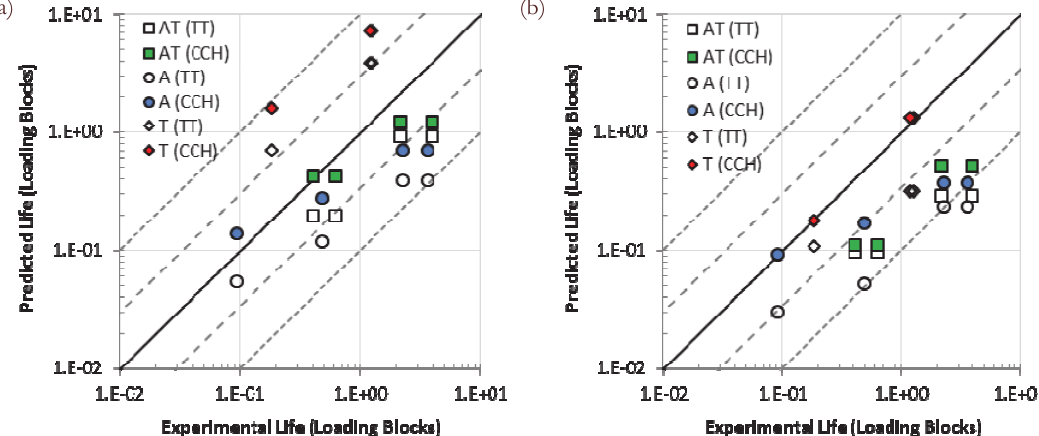
Figure 3: Variable amplitude crack growth life predictions based on (a) FASTRAN and (b) UniGrow analyses.